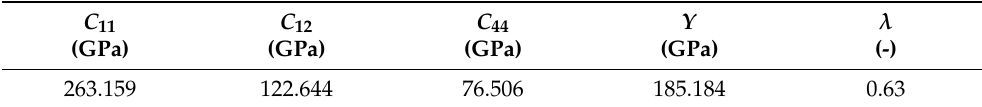
Table 3. Ideal elastic stiffness parameters C 11 , C 12 , and C 44 obtained by DFT calculations, resulting homogenized Young’s modulus Y , and scaling factor λ